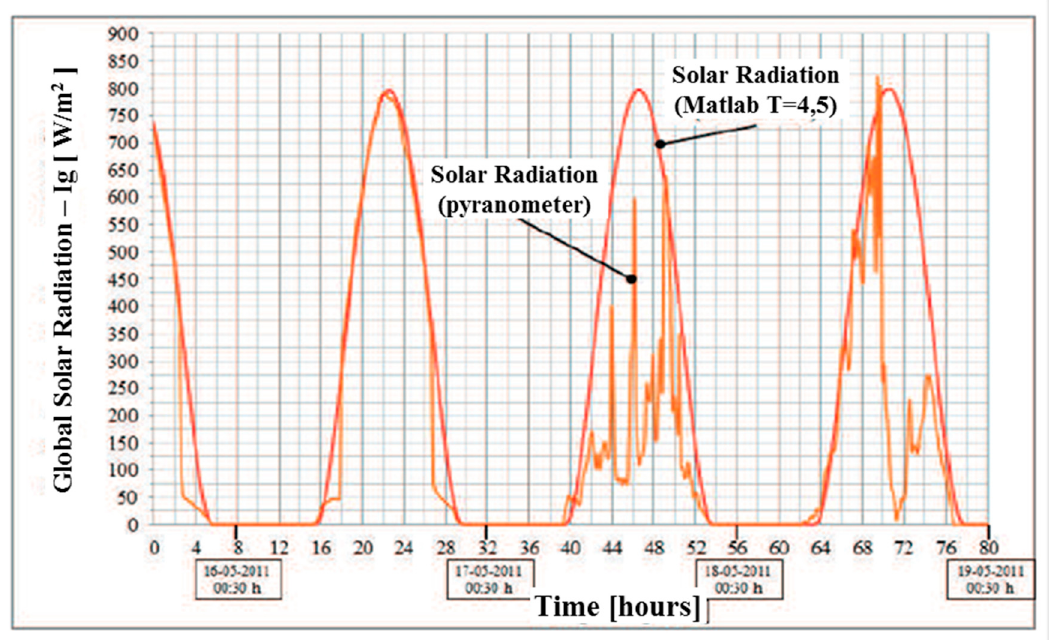
Figure 11. Solar radiation monitored by the pyranometer and estimated by the solar model, for T 1 = 4.5, between 15 and 19 May.